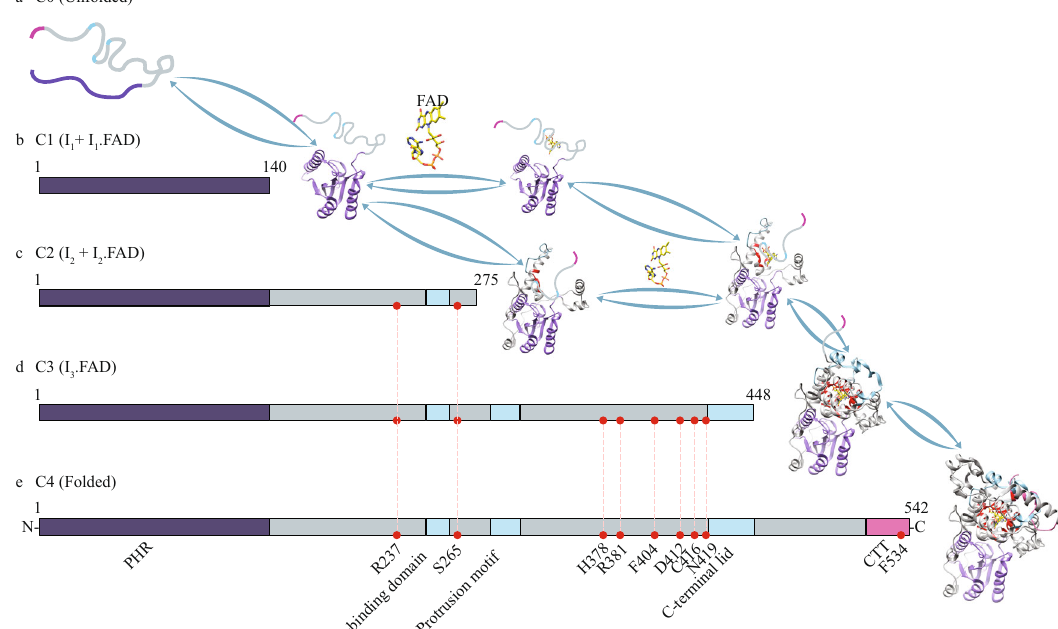
Fig. 5 | Mapping intermediate structures and FAD-binding events along the dCRY folding pathway. a , b The unfolded polypeptide folds into the fi rst inter- mediate(I 1 )thatmatcheswiththesizeofPHR(purple). c I 1 eitherbindsFADtoform I 1 ⋅ FAD or folds into I 2 , which encompasses the Phosphate-binding motif. d I 2 can bind FAD to form I 2 ⋅ FAD, which then folds into I 3 ⋅ FAD that includes folding of the